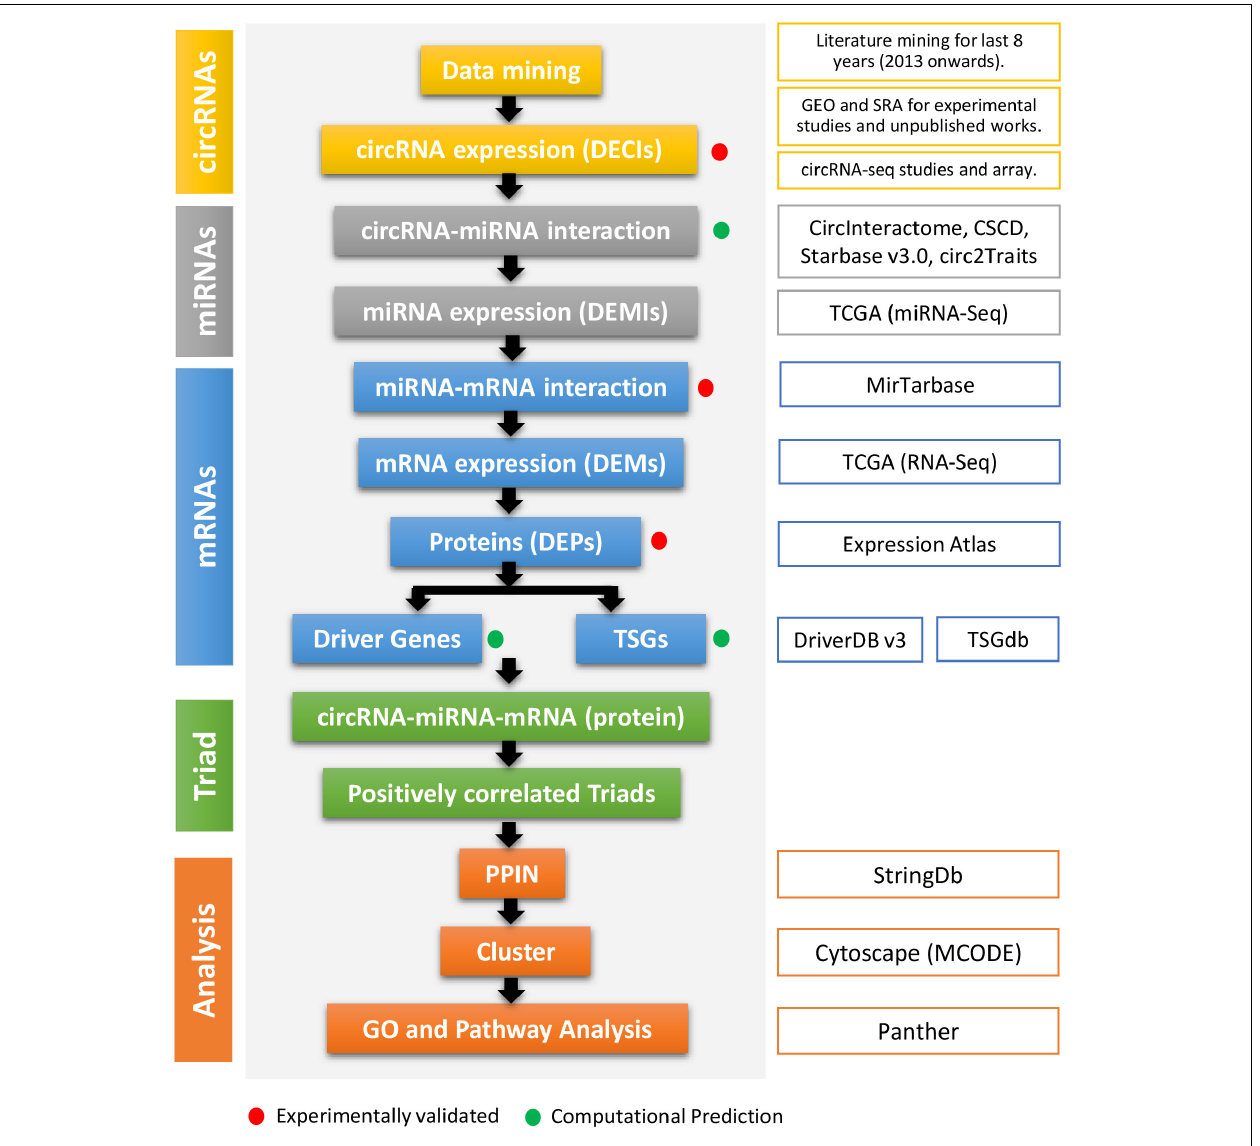
FIGURE 1 | The flowchart of the method used in this study. The first column represents the types of regulatory elements (color-coded). The second column mentions the method cascade. The third column gives the detail about every step, especially the source of the study. The red and green dots represent if the step and output are experimentally validated or computationally